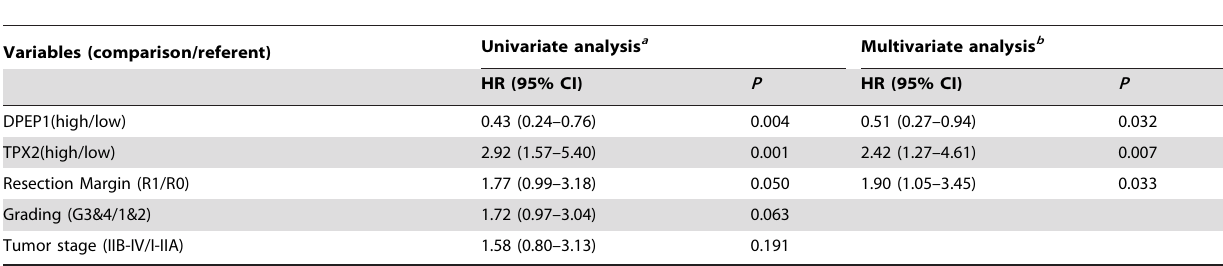
Table 2. Cox regression analysis of DPEP1 and TPX2 expression with caner-specific mortality on combined Germany test cohort and Maryland validation